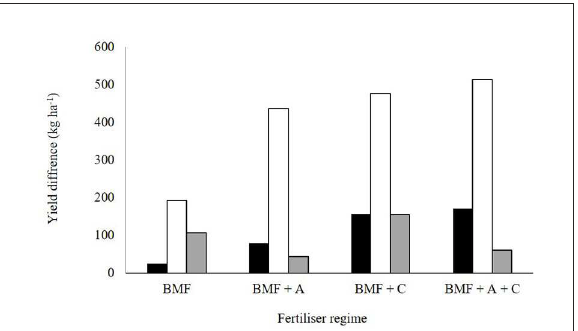
FIGURE2 Absolute seed cotton yield differences (kg ha − 1 ) between conventional tillage and no till at Soaodou (black bars), Okpara (white bars) and Savalou (grey bars). A: 200 kg ha − 1 of